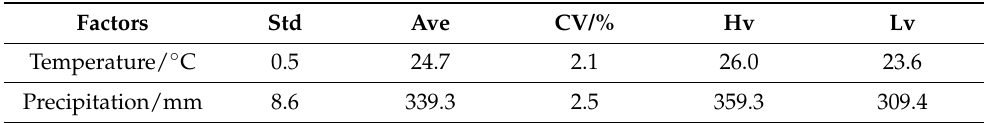
Table 1. Summary of the results of the analysis of the of temperature and precipitation (Ave: average of values for the 48years, Std: standard deviation of the values, CV: coefficient of variation, Hv: highest value, Lv: lowest